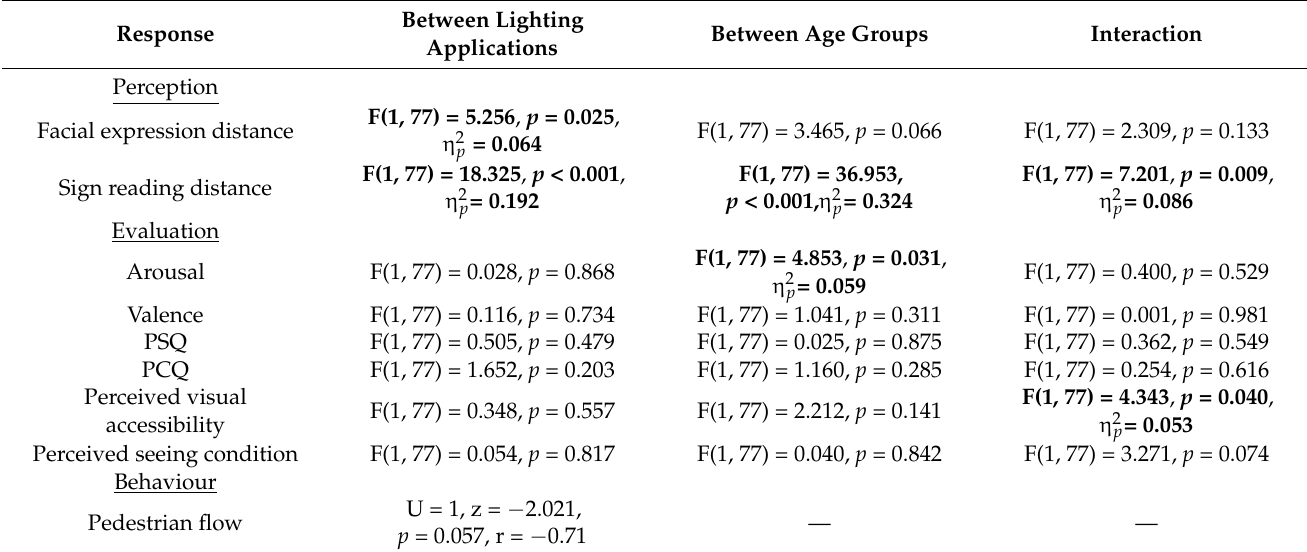
Table 4. The results from the two-way ANOVA and the Mann–Whitney U-test. Significant differences marked in bold.